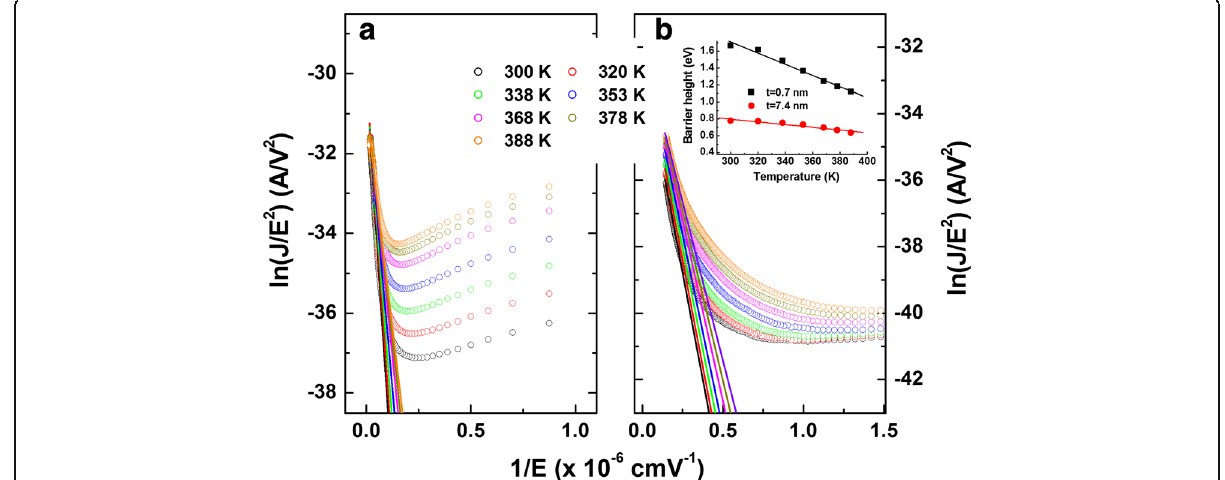
Fig. 9 Fowler – Nordheim (FN) tunneling plots of ln( J / E 2 ) vs. 1/ E with the linear fits to the experimental data for the samples with a 0.7- and b 7.4- nm-thick AlN. The inset in b presents the calculated barrier heights as a function of